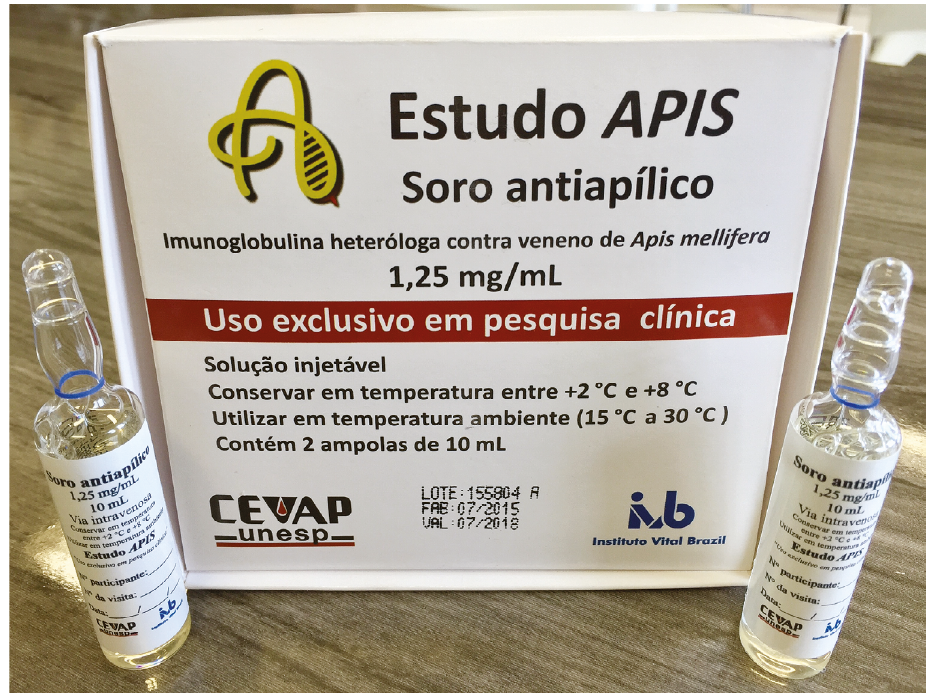
Figure 2. Apilic Antivenom packaging. Reprinted from “Single-arm, multicenter phase I/II clinical trial for the treatment of envenomings by massive Africanized honey bee stings using the unique Apilic Antivenom” by Barbosa et al.